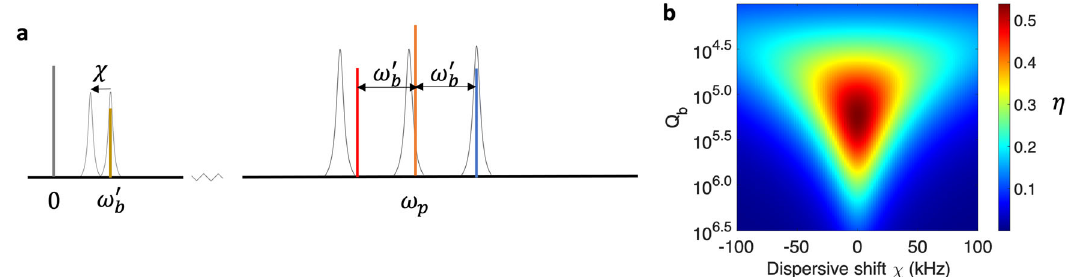
Fig. 5 Transduction in a superconducting QED system with a qubit. a Frequency spectrum for the output signal of the quantum transducer. b Conversion ef fi ciency ( η ) as a function of the microwave quality factor ( Q b , in the logarithmic scale) and the dispersive shift of the microwave resonance frequency induced by the qubit ( χ , in the linear scale).